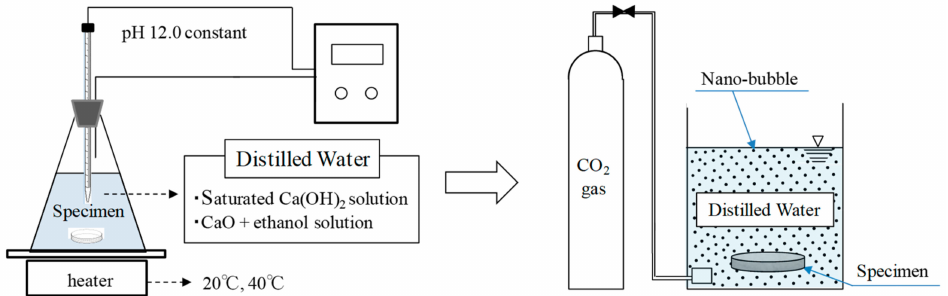
Figure 4. Schematic of experimental protocol for